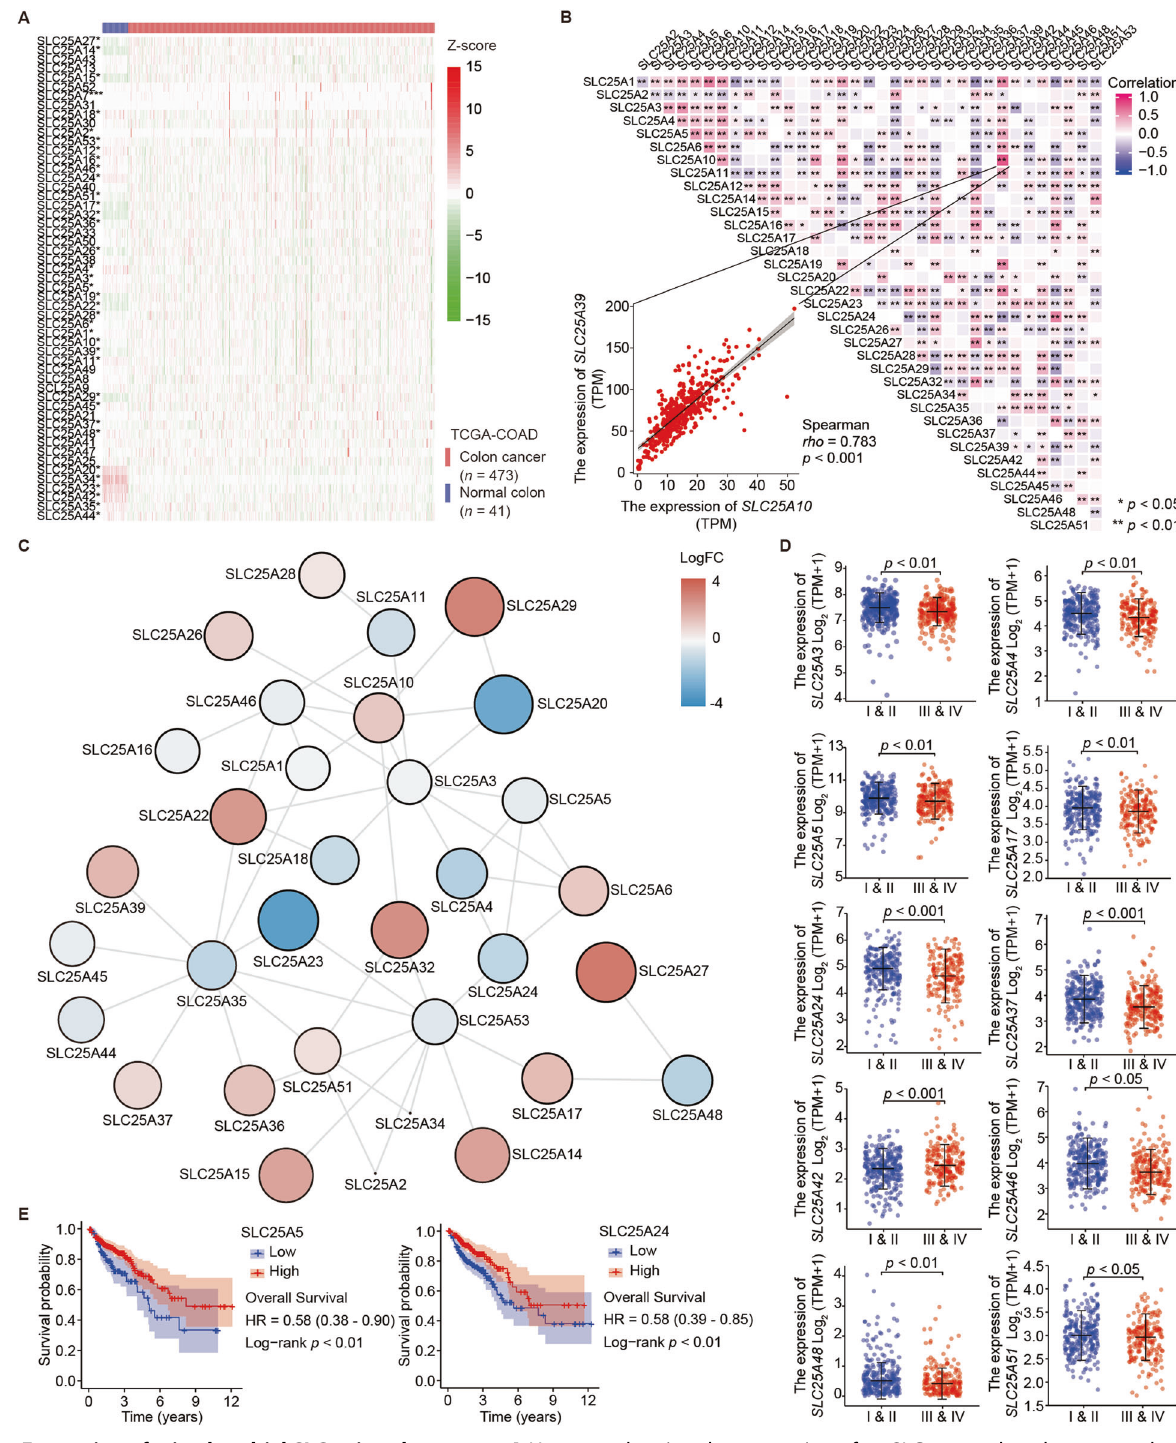
Fig. 2 Expression of mitochondrial SLC25 in colon cancer. A Heatmap showing the expression of 53 SLC25 members between colon cancer and normal colon tissues according to the TCGA-COAD dataset. Thirty-seven of 53 were differentially expressed members (DEMs). B Spearman ’ s rank correlation analyses between 37 DEMs at the transcriptional level. Negative and positive correlations are marked blue and red, respectively. The scatter plot shows the correlation between SLC25A10 and SLC25A39 expression as an illustrative example. C Most of the 37 DEMs interacted at the protein level. The color of the nodes represents the differential expression level, while the size of the nodes indicates the degree of importance in the network. D Ten of 37 DEMs and stage I or II diseases were relevant in this analysis by Wilcoxon rank- sum test, showing that patients with earlier tumor stage tended to have higher mRNA expression of SLC25. E Kaplan – Meier curves suggested that patients with upregulated SLC25A5 and SLC24A24 had a longer overall survival (OS) time.